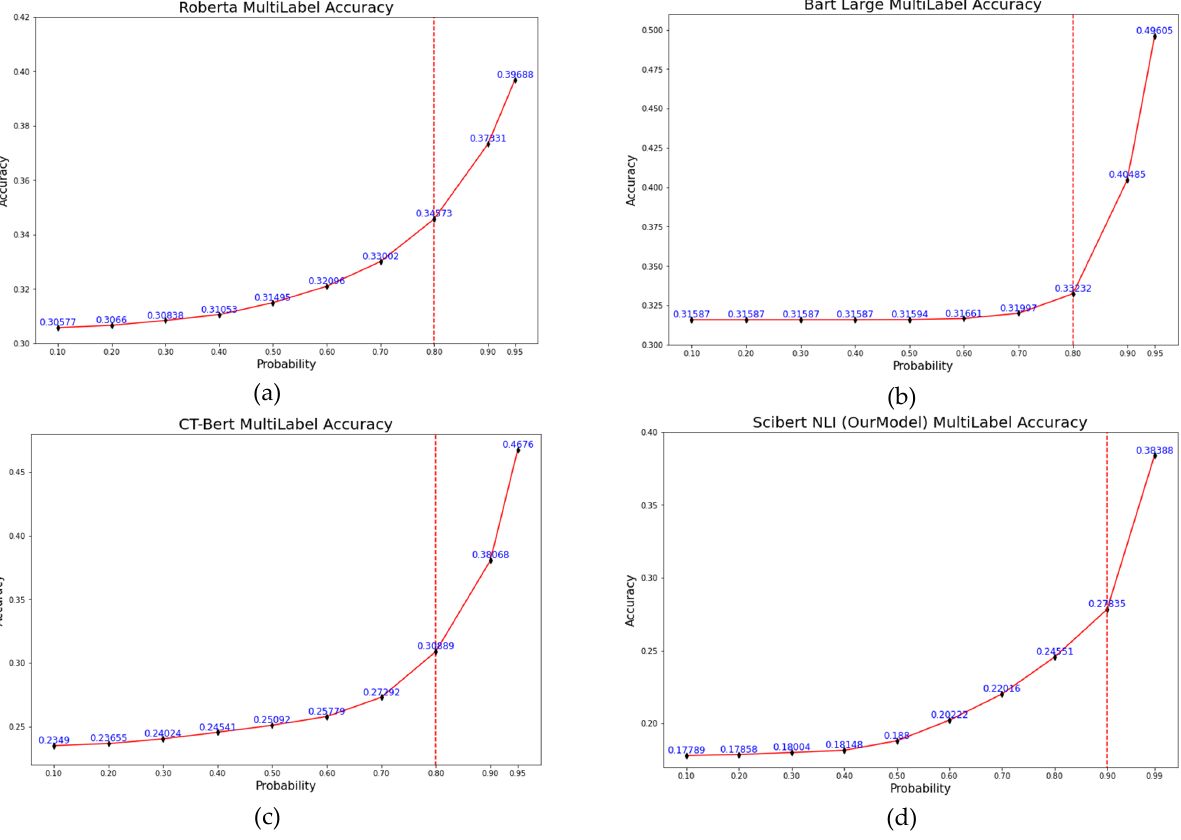
Figure 8. Accuracy vs. Probability graph for all models: ( a ) xlm-robera-large, ( b ) bart-large, ( c ) CT- bert V2, ( d ) Our Model .